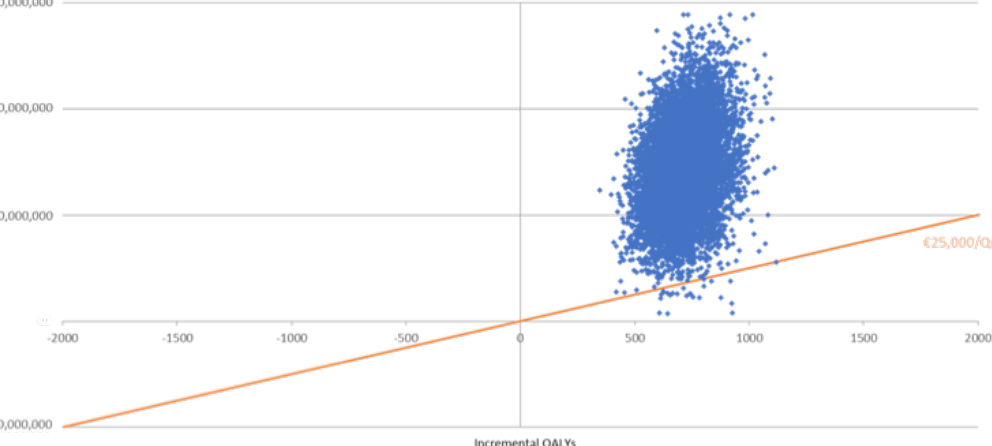
Figure 3. Cost ‐ effectiveness plane for QIVr vs. aQIV in the probabilistic sensitivity analysis (PSA).